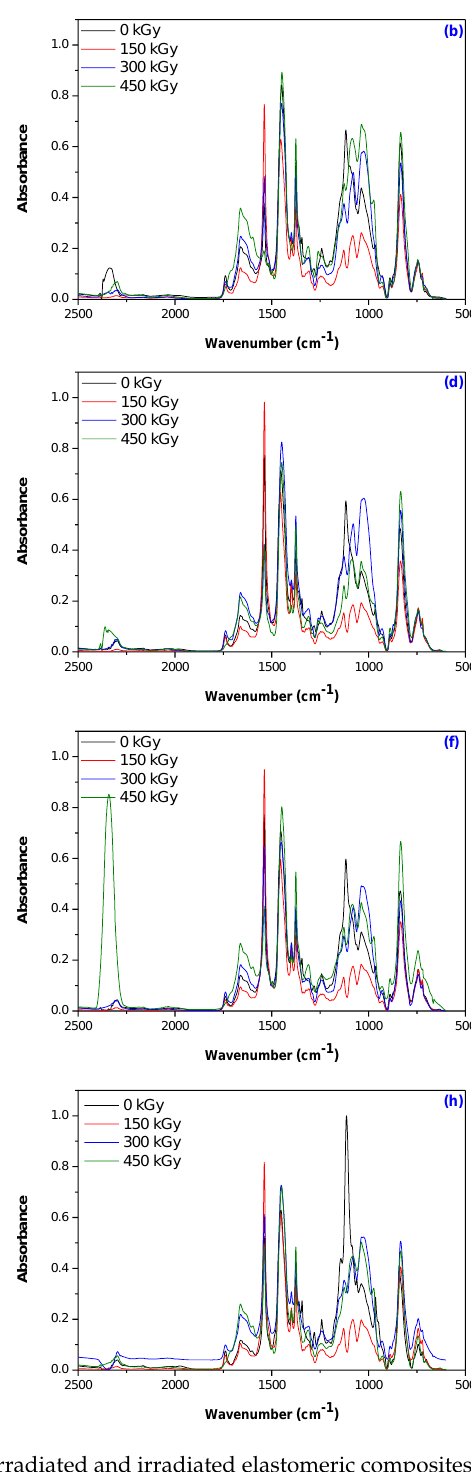
Figure 5. ATR-FTIR spectra of the non-irradiated and irradiated elastomeric composites: mixture A ( a , b ), mixture B ( c , d ), mixture C ( e , f ), and mixture D ( g , h ) in the range of 4000 – 650 cm −1 .